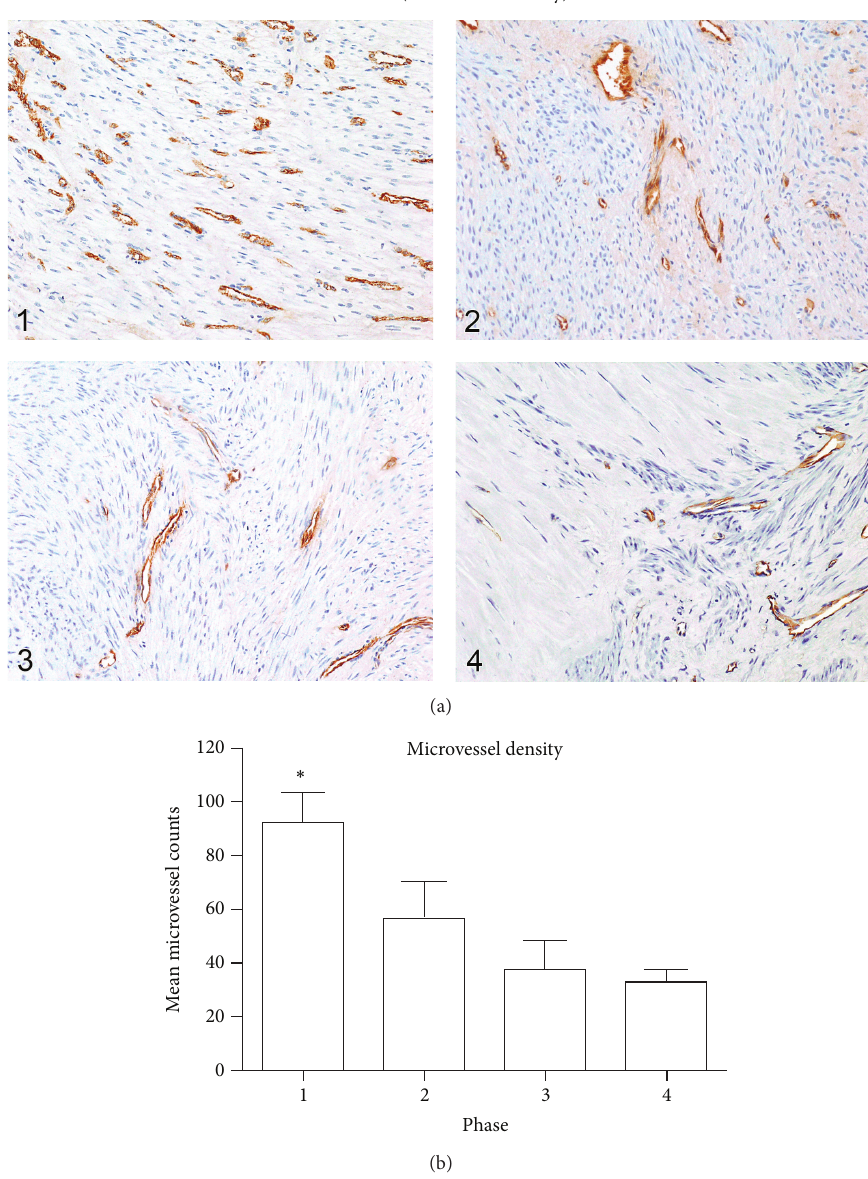
Figure 4: Fibroid phases: microvessel density. (a) In this panel, a representative photo of Factor 8 immunostaining from a fibroid in each of the 4 phases is shown. In some tumors the concentration of vessels was variable from one area to another, and within the fibroids of each phase there was a range of microvessel counts. However, the overall trend was one of decreasing vascularity with progression from phase 1 to 4. In phase 4 tumors, a prominent decrease in microvessel density was often noted within the hypocellular, hyalinized areas, as seen in the left half of the phase 4 tumor in (4). All images were taken with the 10x objective. (b) Bar graph of mean microvessel counts from each phase. Although the microvessel density varied among the individual tumors of each phase, the mean values declined from phase 1 to 4. There were 5 samples per phase group and the values represent the mean ± SEM. ∗ Significantly different from phases 2, 3, and 4 ( 𝑃 < 0.05